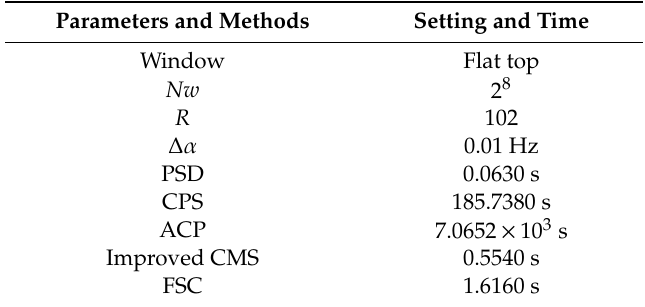
Table 3. Simulated parameters and calculation time used in the five algorithms.